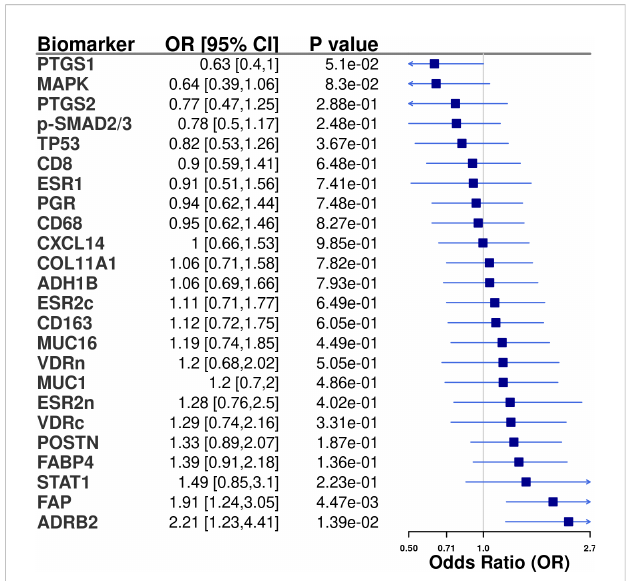
FIGURE 2 Tissue marker associations (odds ratio [OR] and 95% con fi dence intervals [CI]) with optimal debulking status among advanced stage invasive epithelial ovarian cancer cases in NHS/NHSII/NECC (n=166). All models were adjusted for study (NHS/NHSII and NEC). In the logistic regression models 1 = optimally debulked and 0 = sub- optimally debulked.